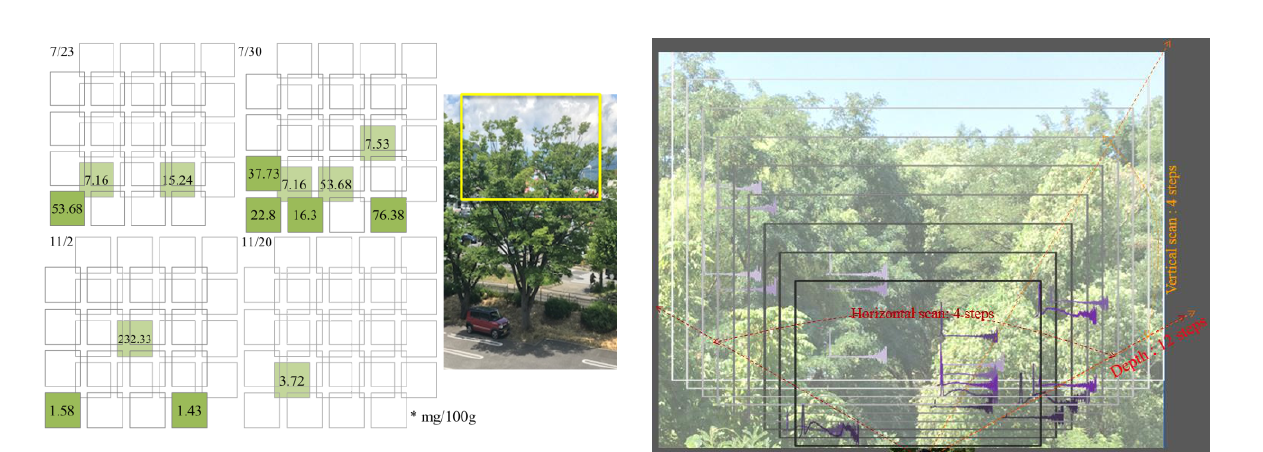
Fig. 4 Distribution map of chlorophyll concentration of a single zelkova tree.